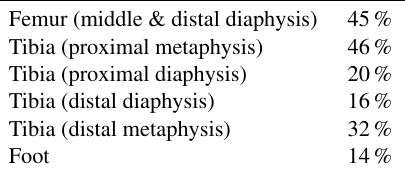
Table 4. Infection frequency (%) by anatomical location. Femur (middle & distal diaphysis) 45% Tibia (proximal metaphysis) 46% Tibia (proximal diaphysis) 20% Tibia (distal diaphysis) 16% Tibia (distal metaphysis)